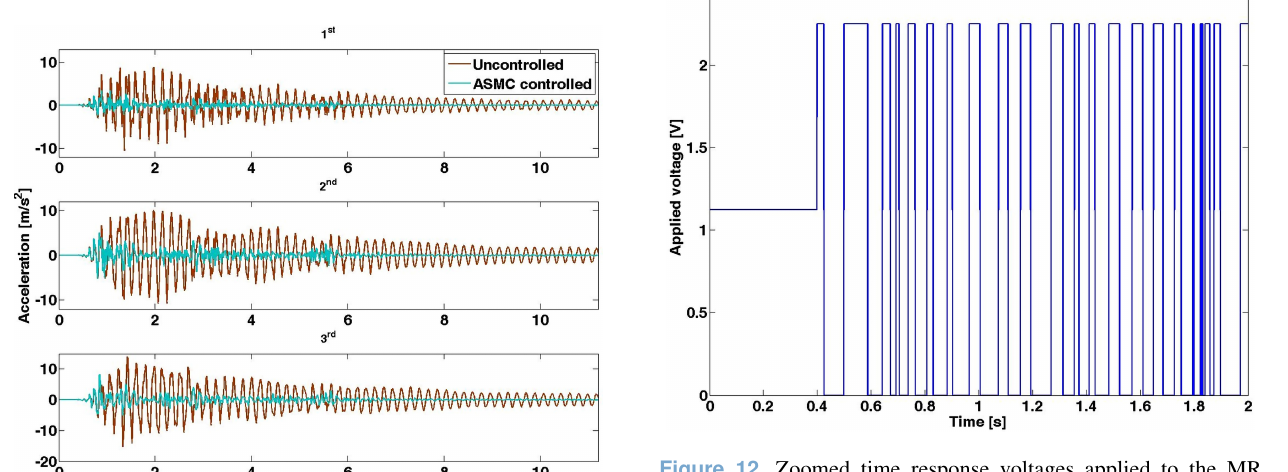
Figure 12. Zoomed time response voltages applied to the MR damper during the 1940 El Centro